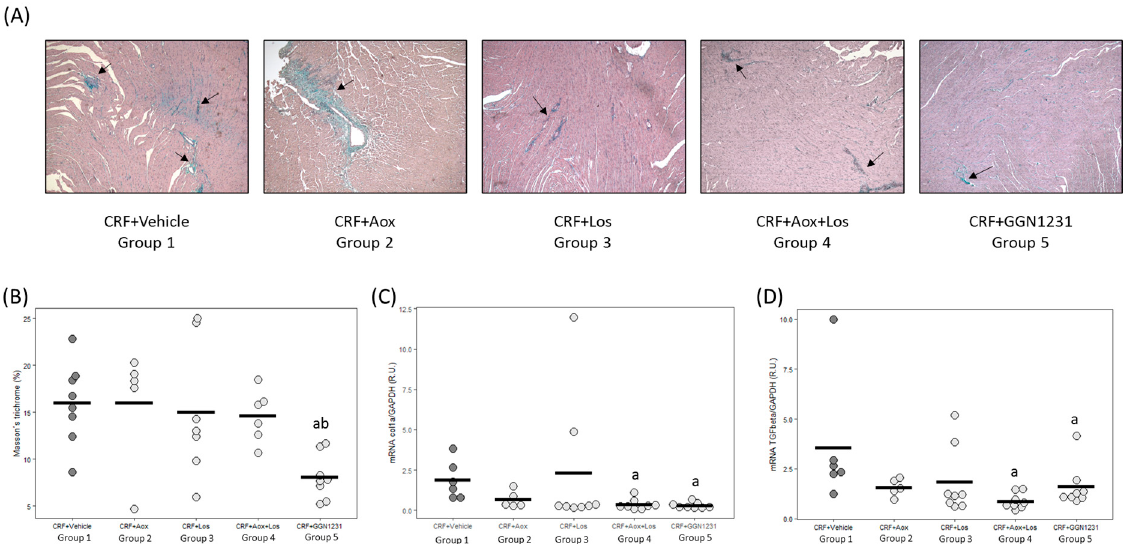
Figure 5. Cardiac fibrosis: Masson’s trichromic staining and Collagen I and TGF- β 1 gene expression evaluated by qPCR. ( A ) Representative photos of Masson’s trichrome staining (10×). The arrows point to areas with fibrosis. ( B ) Masson’s trichrome staining quantification in all rats. ( C ) Collagen I (Col I) mRNA. ( D ) TGF- β 1 mRNA. CRF (chronic renal failure); Aox (antioxidant); Los (losartan); Aox+Los (antioxidant plus losartan); GGN1231 (antioxidant plus losartan hybrid). Data represent mean values per group in horizontal lines in the bee swarm graphic. a p < 0.05 versus CRF + vehicle; b p < 0.05 versus CRF + Aox.